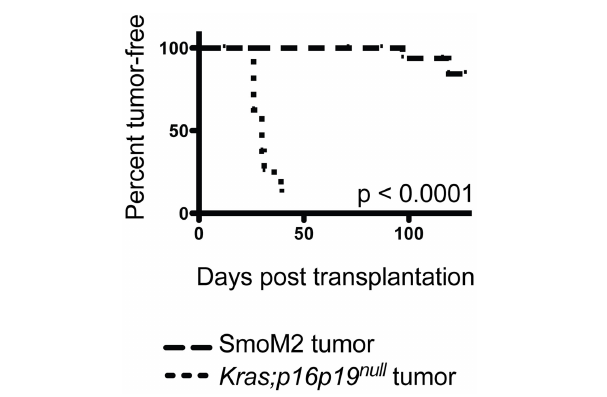
FIGURE 3 | Kras; p16p19 null tumor cells repopulate tumors in secondary recipients more effectively than SmoM2 mouse tumor cells . Pi − Ca + GFP + Kras; p16p19 null tumor cells were sorted independently from two primary tumors and injected into the cardiotoxin-pre-injured gastrocnemius muscles of NOD.SCID mice (50 cells per injection). Pi-Ca + SmoM2 tumor cells were sorted independently from four primary